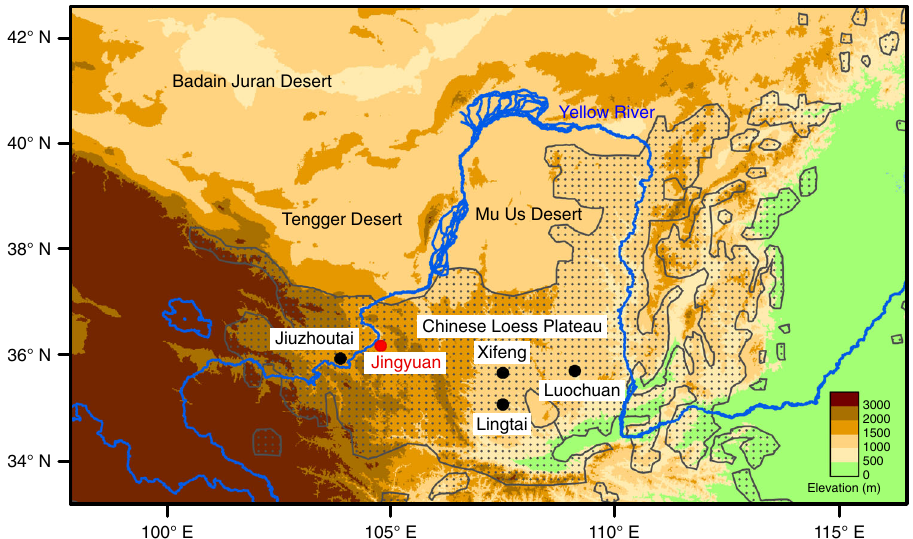
Fig. 1 Location of JY loess core and representative loess pro fi les on the Chinese Loess Plateau (CLP). Black dots denote four classic loess pro fi les, which have been investigated intensively as the Quaternary stratotype sections 25 – 31 . Red dot indicates the Jingyuan loess pro fi le accumulated on the ninth terrace of the Yellow River in the northwestern CLP